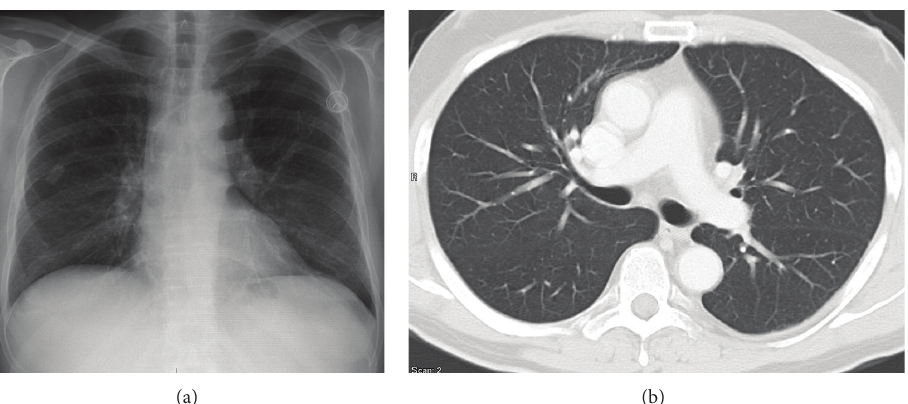
Figure1:X-ray(onedayafterinpatientadmittance)andCTscanofthechest(onemonthpriortofirstchemotherapyadministration).Normal finding in both